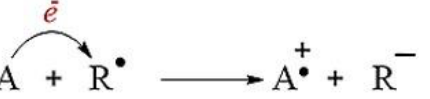
tacked by the free radical and can follow path I, where it transfers an H- atom to R∙, or path II, where it transfers one electron to